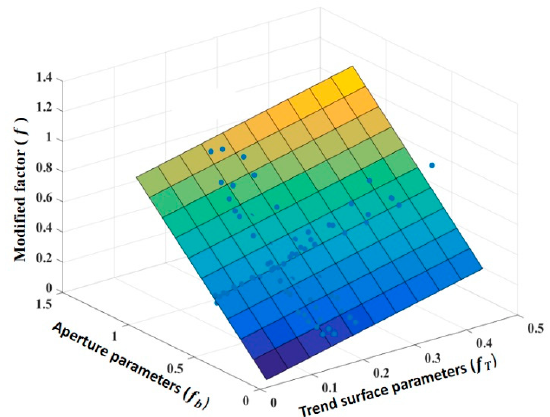
Figure 14. The fitted surface for the data of triple ( f T , f b , f ) with the equation of Equation